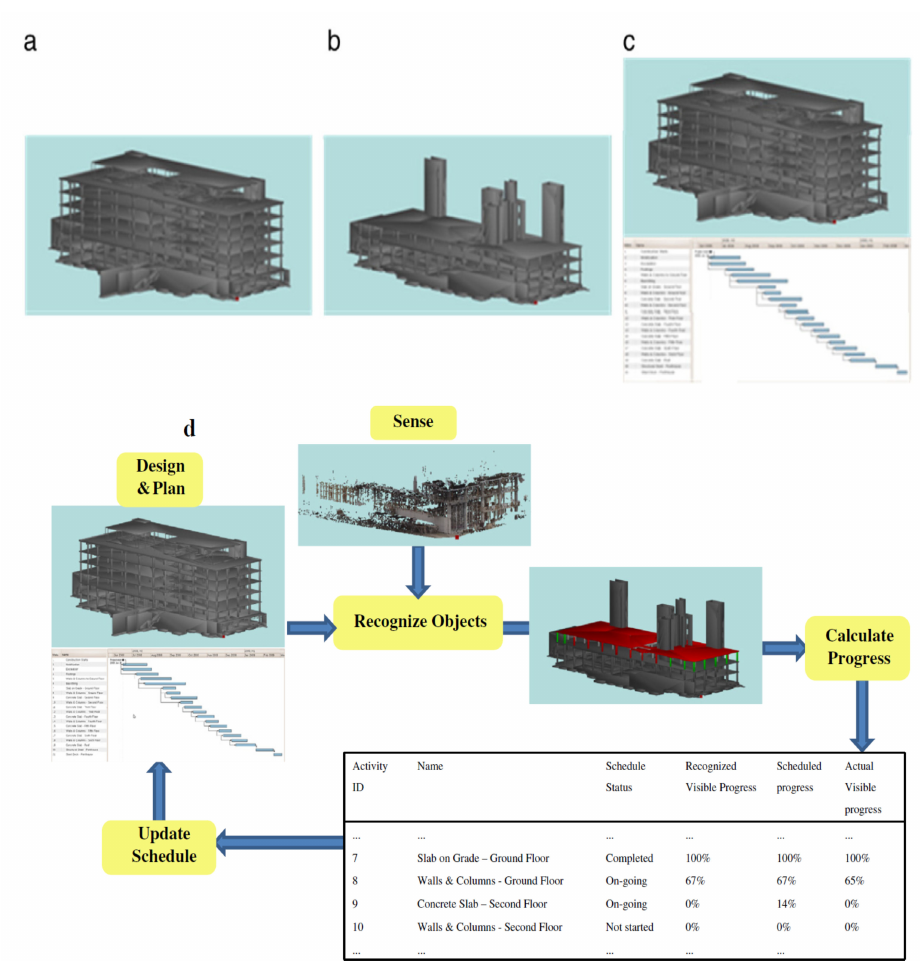
Figure 11. ( a ) 3D model, ( b ) time-stamped 3D model, ( c ) 4D model, and ( d ) procedure for automated progress calculation and schedule update